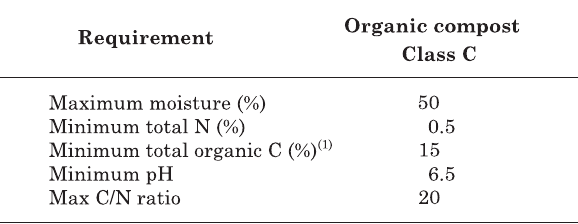
Table 1. Chemical characteristics of compost and soil before compost amendment Table 2. Minimum compost specifications to meet minimum legal requirements